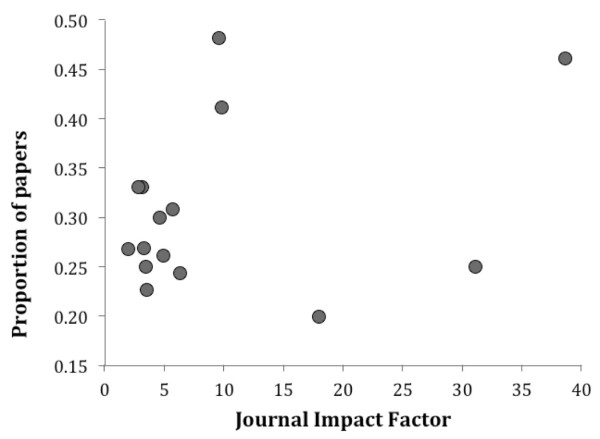
The proportion of ‘promiscuity’ papers in a journal was not associated with its Impact Factor (2012 Journal Citation Reports, Thomson Reuters) (Spearman’s ρ = 0.03, p > 0.9).